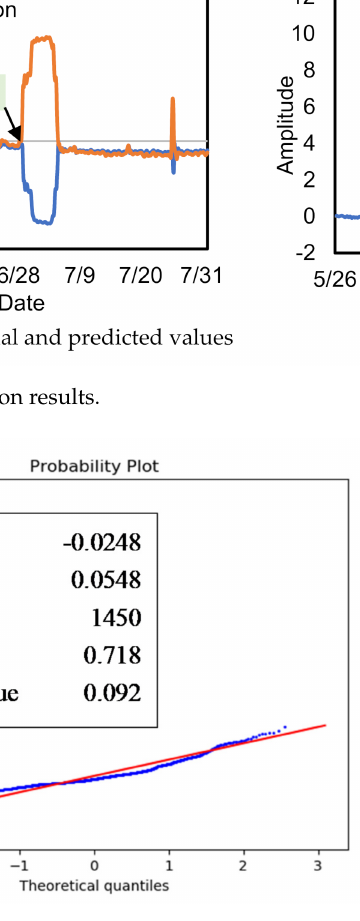
Figure 9. Normality test. The mean and variance estimates of health signal residuals and the hyperparameters were obtained from the validation set. The mean x = 0.00716 and variance s 2 = 0.002 of the validation set residuals of the trained LSTM model. The prediction model was retrained six times, and the mean and variance of each time are shown in Table 1. The final estimated mean ˆ µ = 0.006265 and variance ˆ σ 2 = 0.002181 were used as the criteria for the subsequent evaluation. The variation in the mean was within ± 0.004 of the estimate, and the variation in the residuals was within ± 0.0005. The hyperparameters can then be solved according to Equations (14) and (20), as shown in Table